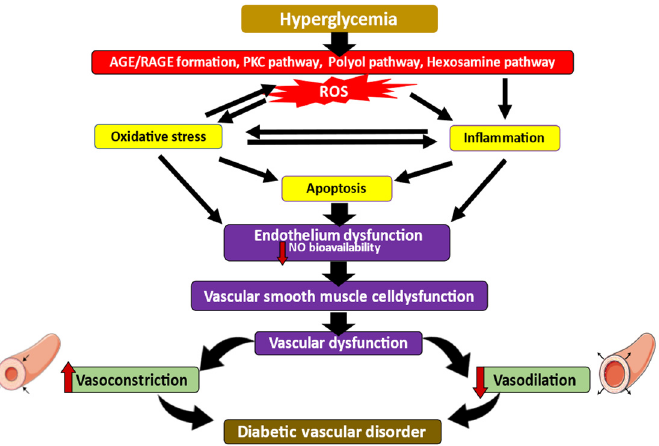
Figure 1. Hyperglycemia induces activation of AGE/RAGE formation, PKC pathway, polyol pathway, and hexosamine pathway and leads to ROS generation. Elevated ROS causes oxidative stress and inflammation which further trigger the apoptosis pathway. This condition will induce endothelium dysfunction by reducing the NO bioavailability. Together, all these processes will cause vascular dysfunction, resulting in diabetic vascular disorder.